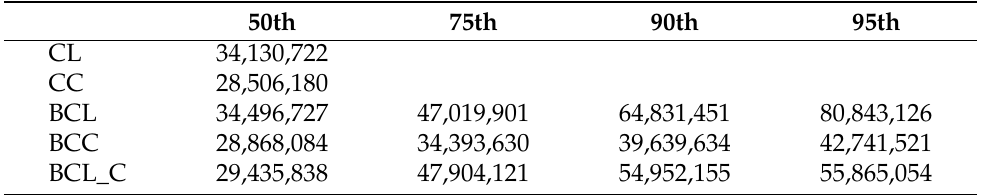
Table 12. Computed quantiles of reserves with outlier without using the heat equation in two dimensions.